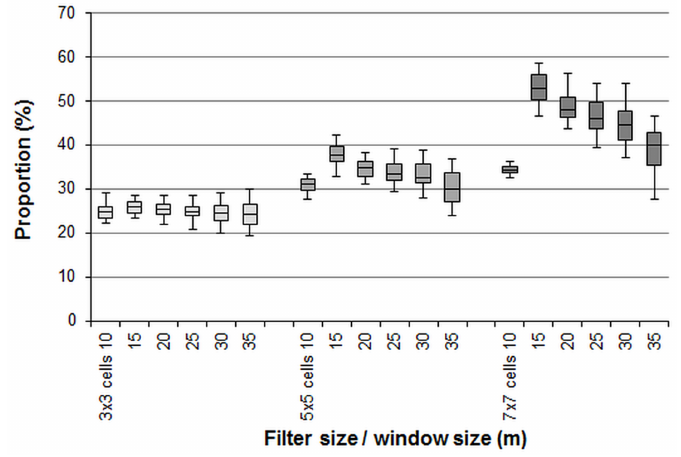
Figure 6. Proportions of incorrectly classified cells depending on the moving window size used for the patch classification and the kernel filter size used for the noise